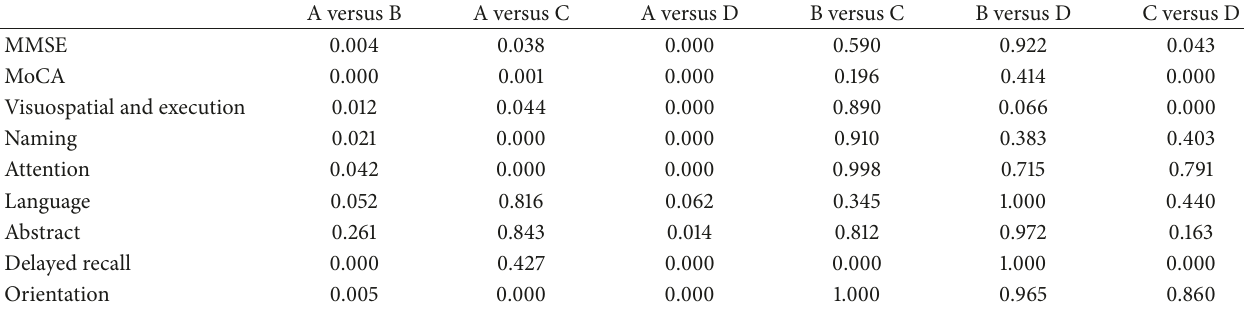
Table 4: Cognitive function characteristic analysis comparing the PD-SD, PD-NSD, primary sleep disorders, and normal control groups.